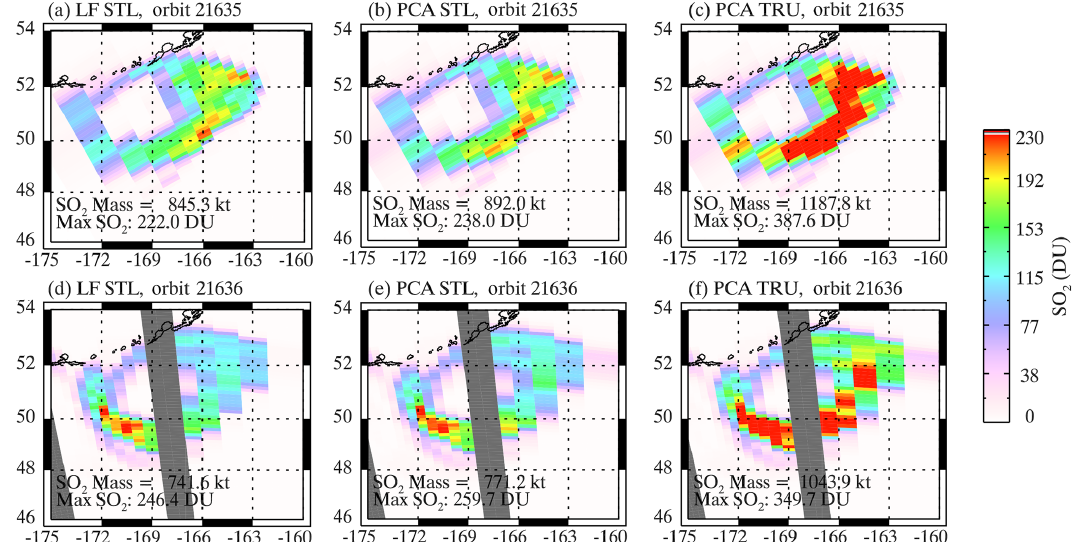
Figure 5. (a) OMI linear fit SO 2 retrievals assuming a lower stratospheric (STL) SO 2 profile for orbit 21635, the first OMI overpass after the Kasatochi eruption on 8 August 2008. ( b – c ) Same as (a) but for OMSO2VOLCANO (PCA) retrievals assuming (b) the STL SO 2 profile and (c) an upper tropospheric (TRU) SO 2 profile. (d) Linear fit STL retrievals for orbit 21636, the second OMI overpass after the eruption. ( e – f ) Same as (d) but for OMSO2VOLCANO (e) STL and (f) TRU retrievals. The gray-shaded rows in ( d – f ) are masked due to the OMI row anomaly. If retrievals for these masked rows are included in the calculation of the total loading, the total LF STL SO 2 mass in the domain for orbit 21636 is 864.7kt (see Krotkov et al., 2010), whereas PCA total mass in the domain is 897.2kt and 1204.9kt for STL and TRU retrievals, respectively.